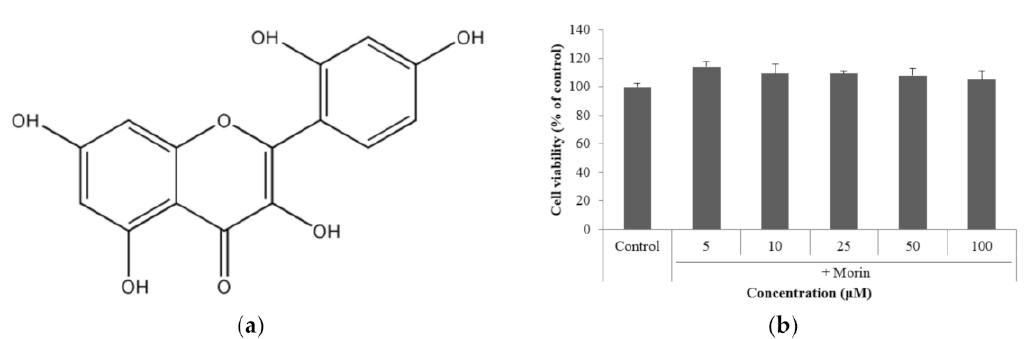
Figure 1. ( a ) Chemical structure of morin. ( b ) Effect of morin on the viability of B16F10 mouse melanoma cells. Cells were treated with morin (5, 10, 25, 50, and 100 µ M) for 48 h. The data are presented as the mean ± SD of at least three independent experiments.